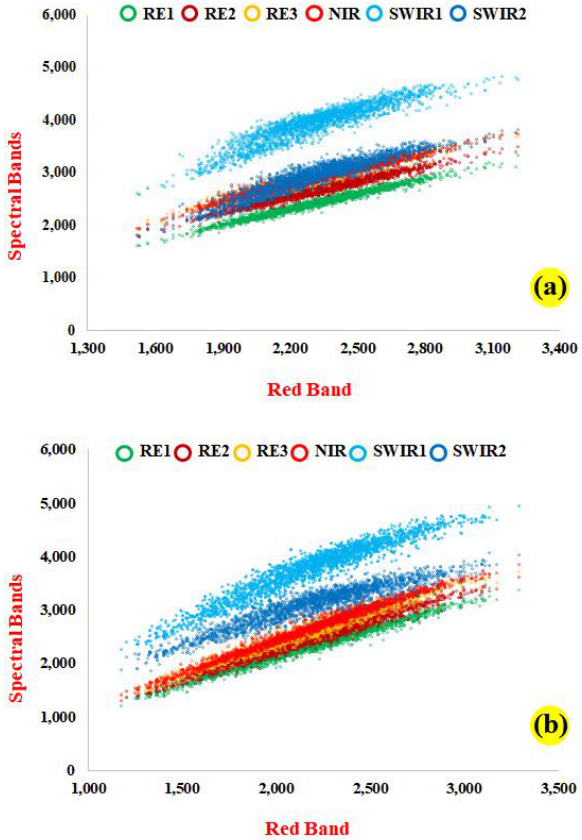
Figure 5. Scatter plot for vegetated areas in the different spectral bands; pre-fire (a), post-fire